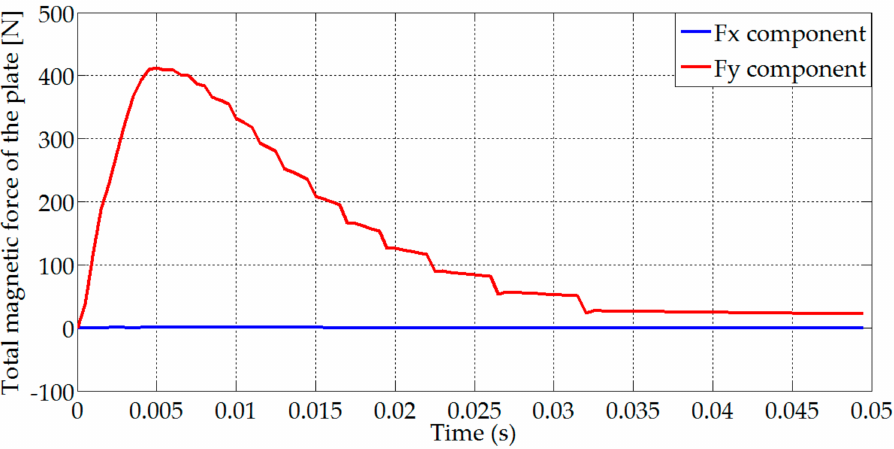
Figure 10. Total volume magnetic force components on the non-linear magnetic and conductive VACOFER S1